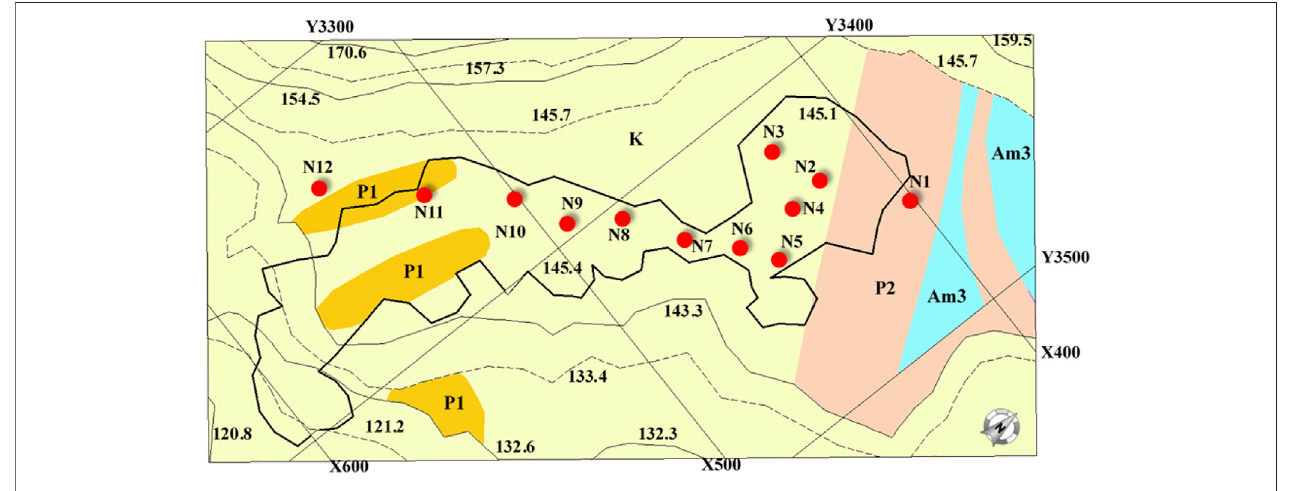
FIGURE 5 | Detailed arrangement scheme of the